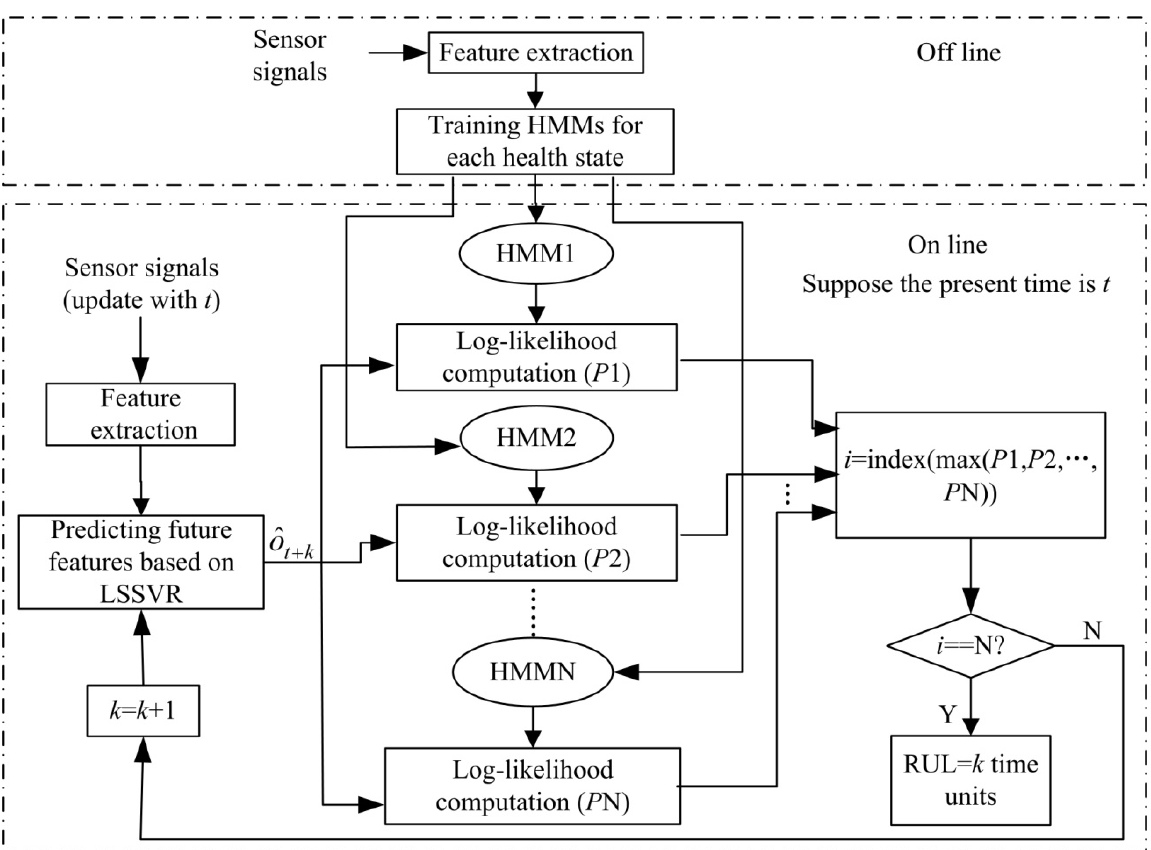
Figure 2. Framework of the LSSVR/HMM fault prognostics scheme which contains two processes. One is HMMs training (off line) and another is fault feature and RUL prediction process (on